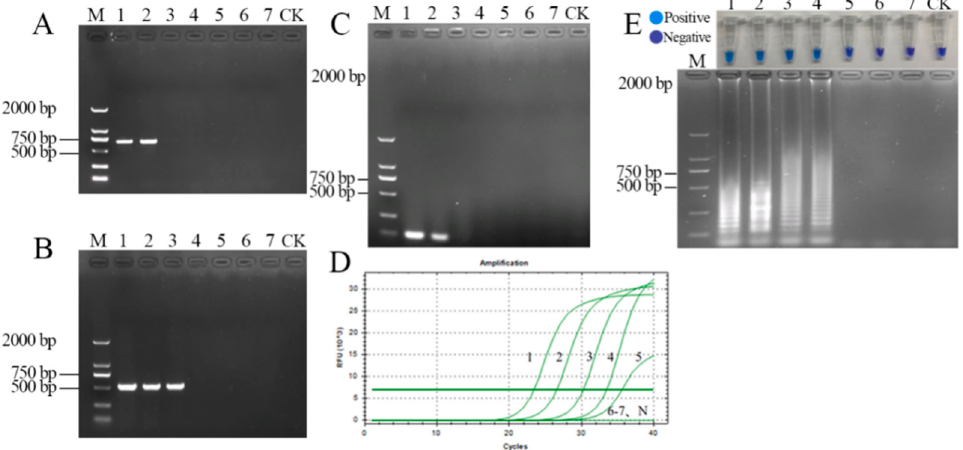
Figure 9. Sensitivity test of seminested PCR, real-time quantitative PCR, and LAMP for the detection of A. phaeospermum ( A ) Sensitivity of conventional PCR for the detection of A. phaeospermum with the AP1-1/AP1-2 primer; ( B ) sensitivity of seminested PCR for the detection of A. phaeospermum with the AP1-1, AP1-2, and AP1-3 primers; ( C ) sensitivity of conventional PCR for the detection of A. phaeospermum with the 33-F/33-R primer; ( D ) sensitivity of qPCR for the detection of A. phaeosper- mum ; ( E ) sensitivity of LAMP for the detection of A. phaeospermum . M: DL 2000 DNA marker; 1–7: DNA concentrations were 10 ng/ μ L, 1 ng/ μ L, 100 pg/ μ L, 10 pg/ μ L, 1 pg/ μ L, 100 fg/ μ L, and 10 fg/ μ L, respectively; CK: negative control.